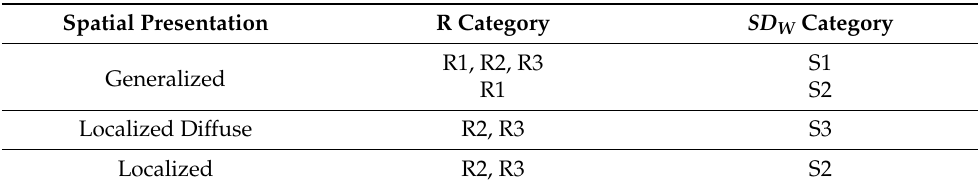
Table 2. R and S pairings for spatial presentation categories. Categories of excess lung fluid are based on the metrics given in Table